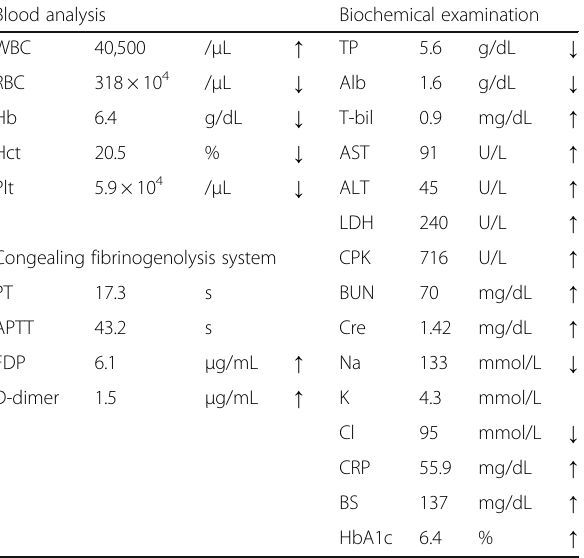
Blood analysis Biochemical examination